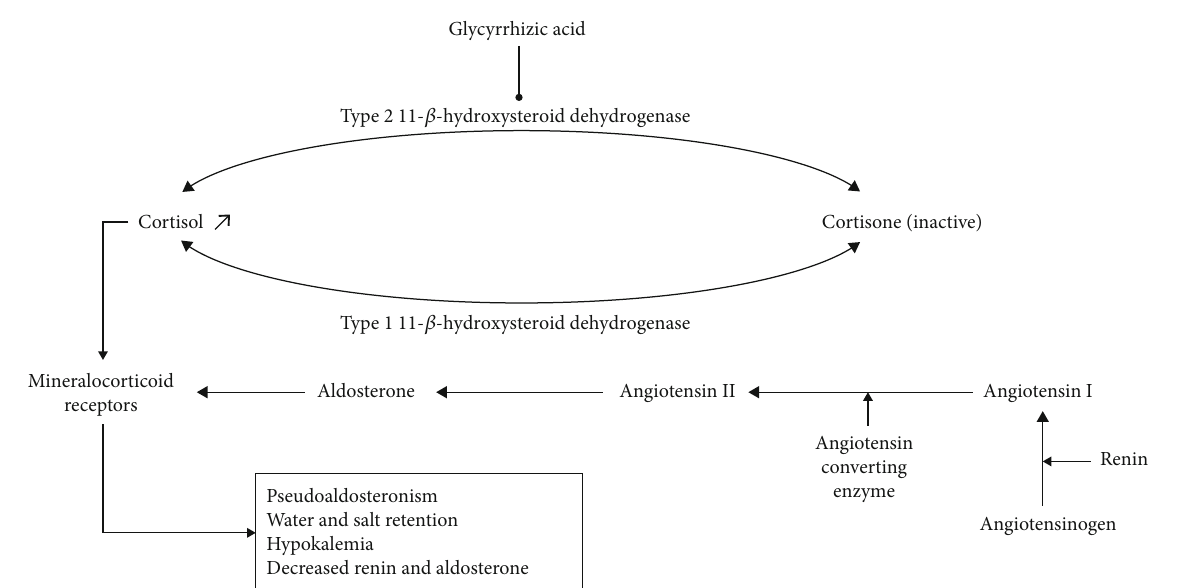
Figure 1: Both cortisol and aldosterone bind with equal a ffi nity to mineralocorticoid receptors that are activated predominantly with aldosterone. Type 2 11- β -hydroxysteroid dehydrogenase (11- β HSD) converts cortisol to its inactive form, cortisone, and evokes corticosteroid speci fi city. By inhibitory e ff ects of Glycyrrhiza glabra and glycyrrhizin on type 2 11- β HSD, the mineralocorticoid receptors are activated by cortisol, leading to accumulation of glucocorticoids with anti-in fl ammatory and mineralocorticoid properties, hypokalemia, and mineralocorticoid-related